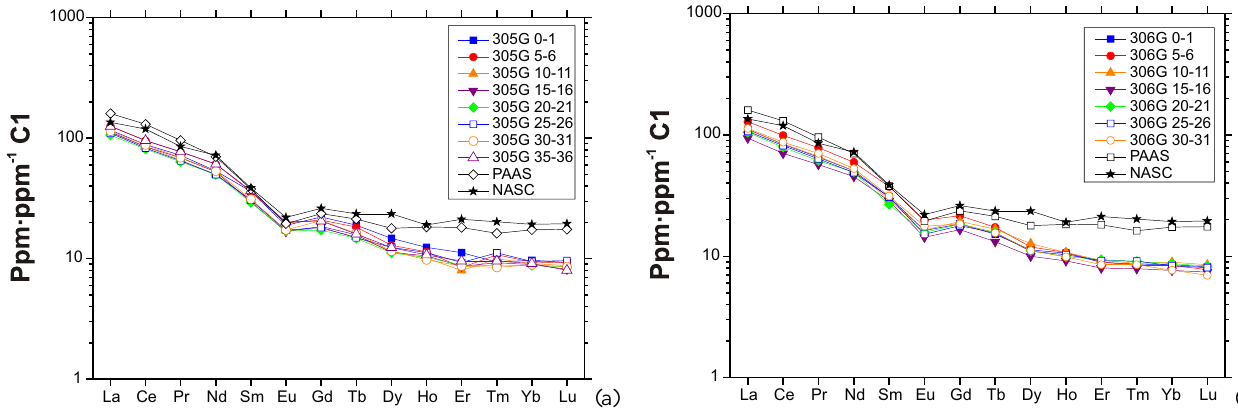
Fig. 4. CI chondrite-normalized REEs patterns (ppmppm − 1 CI) every five centimetres for cores 305G (a) and 306G (b) compared with the standard REE pattern of the NASC and the PAAS (McLennan, 1989).